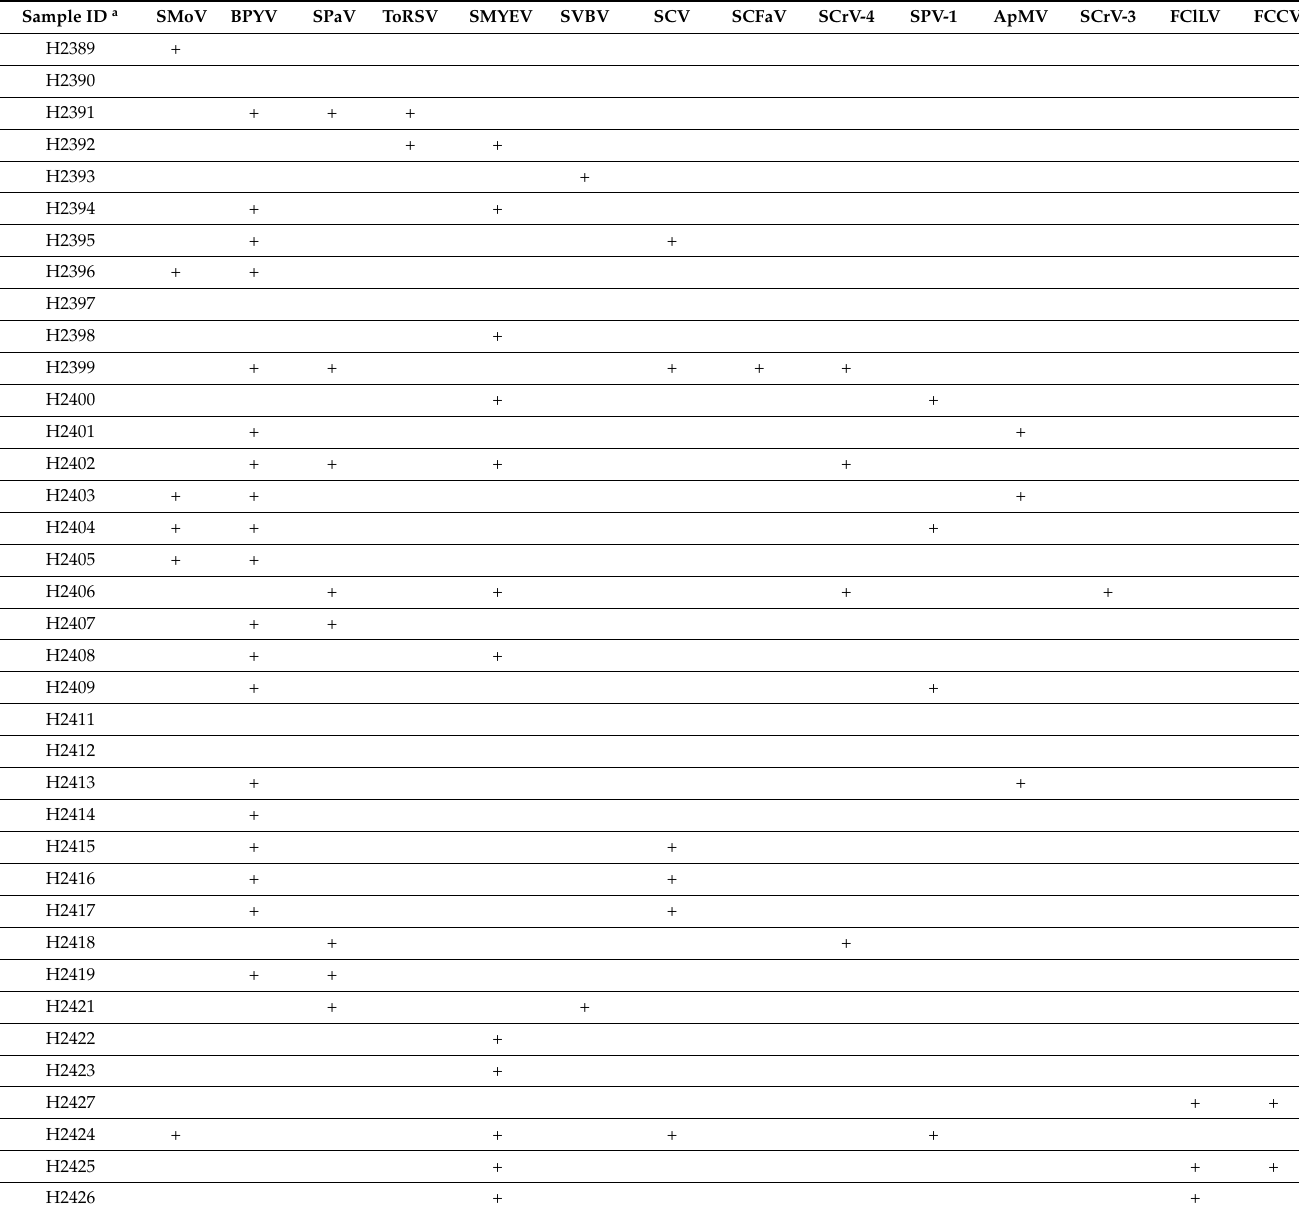
Table 1. Viruses identified in strawberry plants via high throughput sequencing (HTS). Plants originated from the National Clonal Germplasm Repository (NCGR) located in Corvallis, Oregon. Sample ID a SMoV